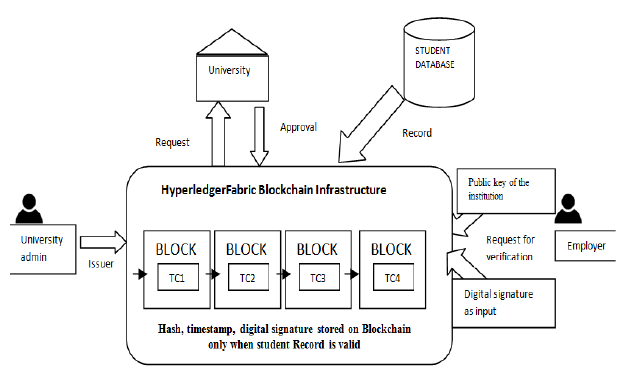
Figure 1. The proposed model to authenticate the digital